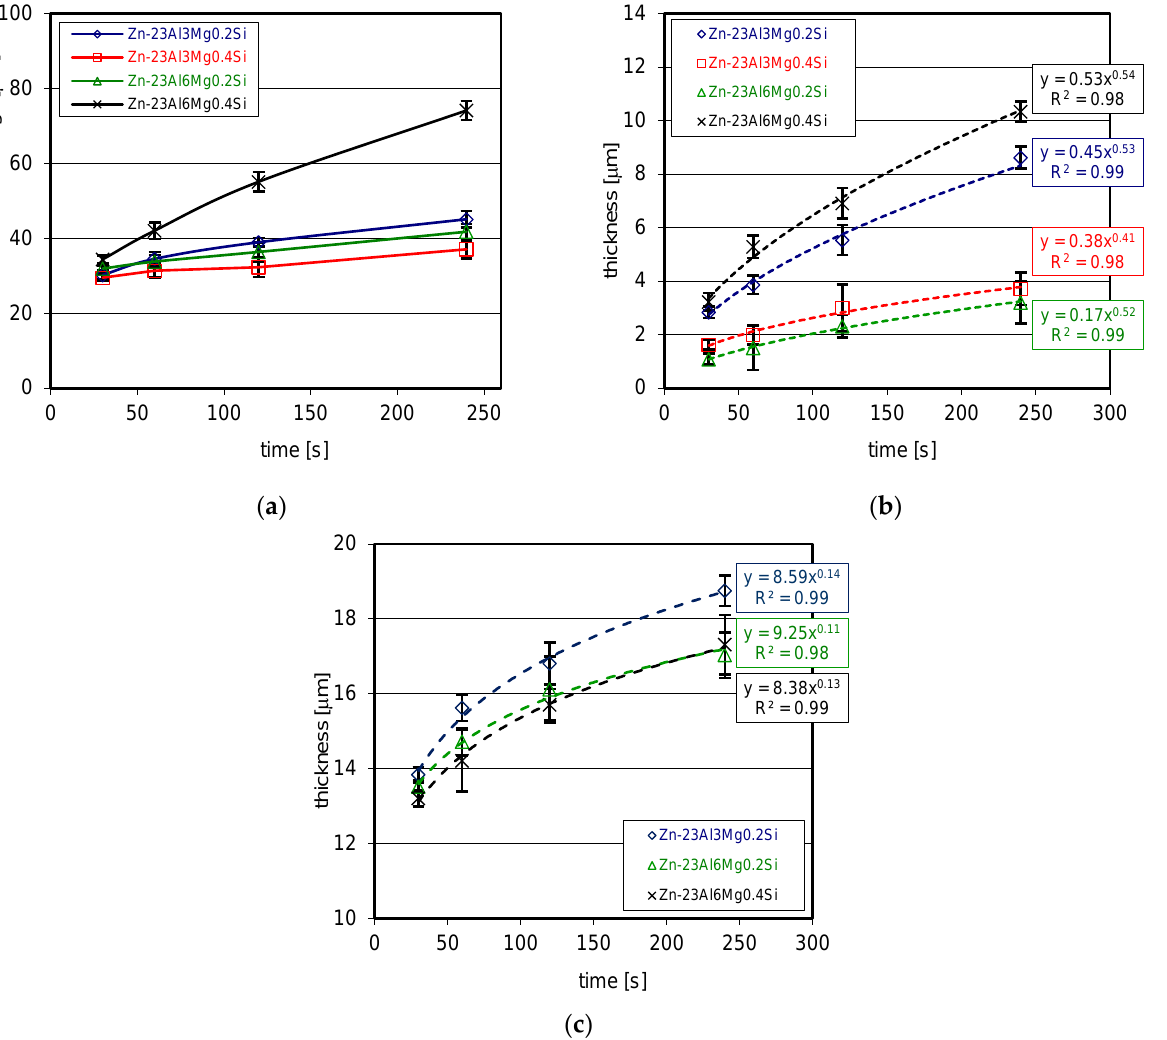
Figure 6. Growth kinetics of research coatings: ( a ) total thickness of the coating, ( b ) thickness of the compact layer and ( c ) thickness of the layer with a heterogeneous structure.